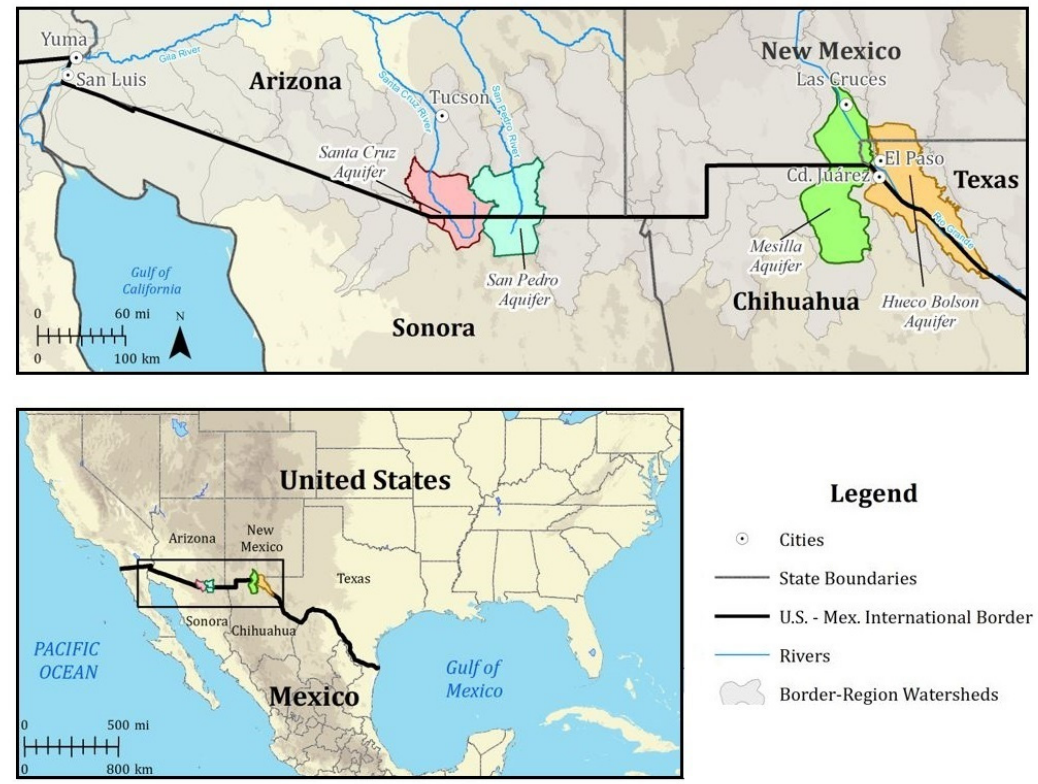
Figure 1. TAAP’s aquifers of focus on the Mexico–US border.